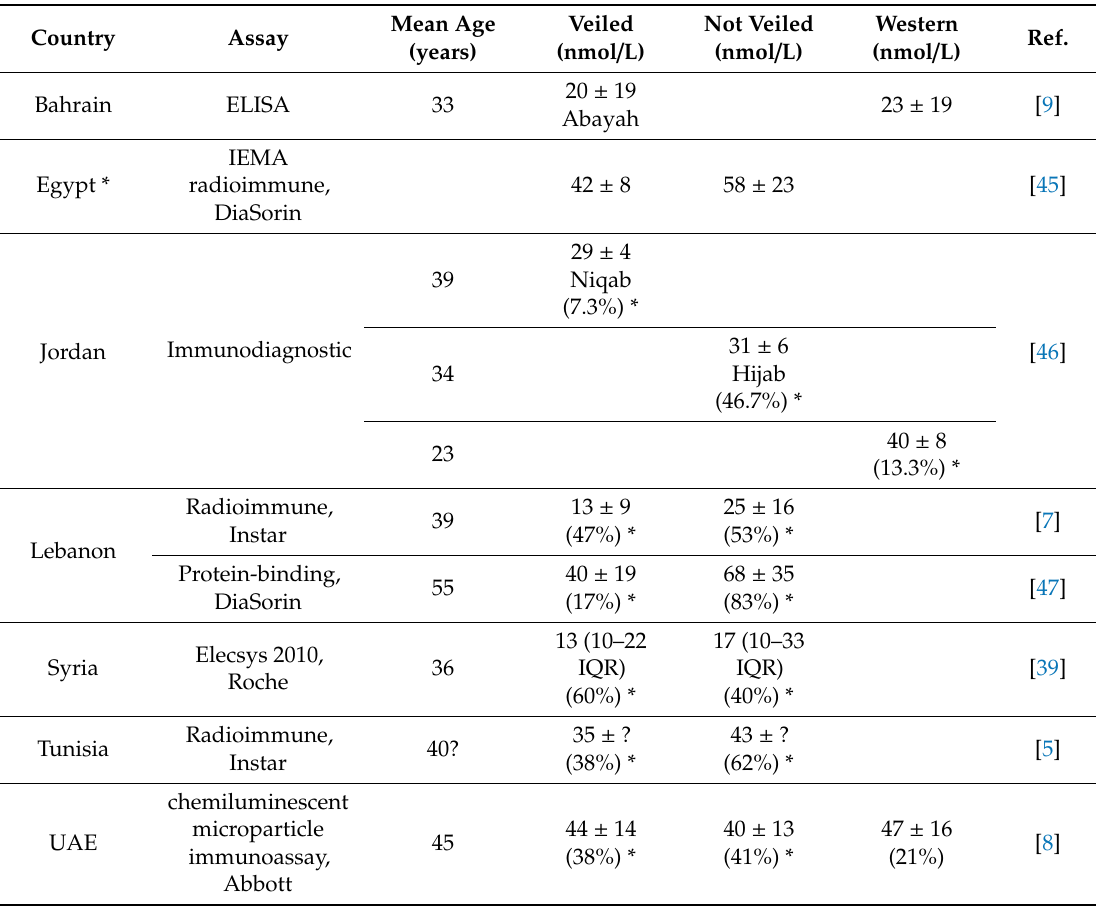
Table 8. Influence of clothing style on 25(OH)D concentrations in the Middle